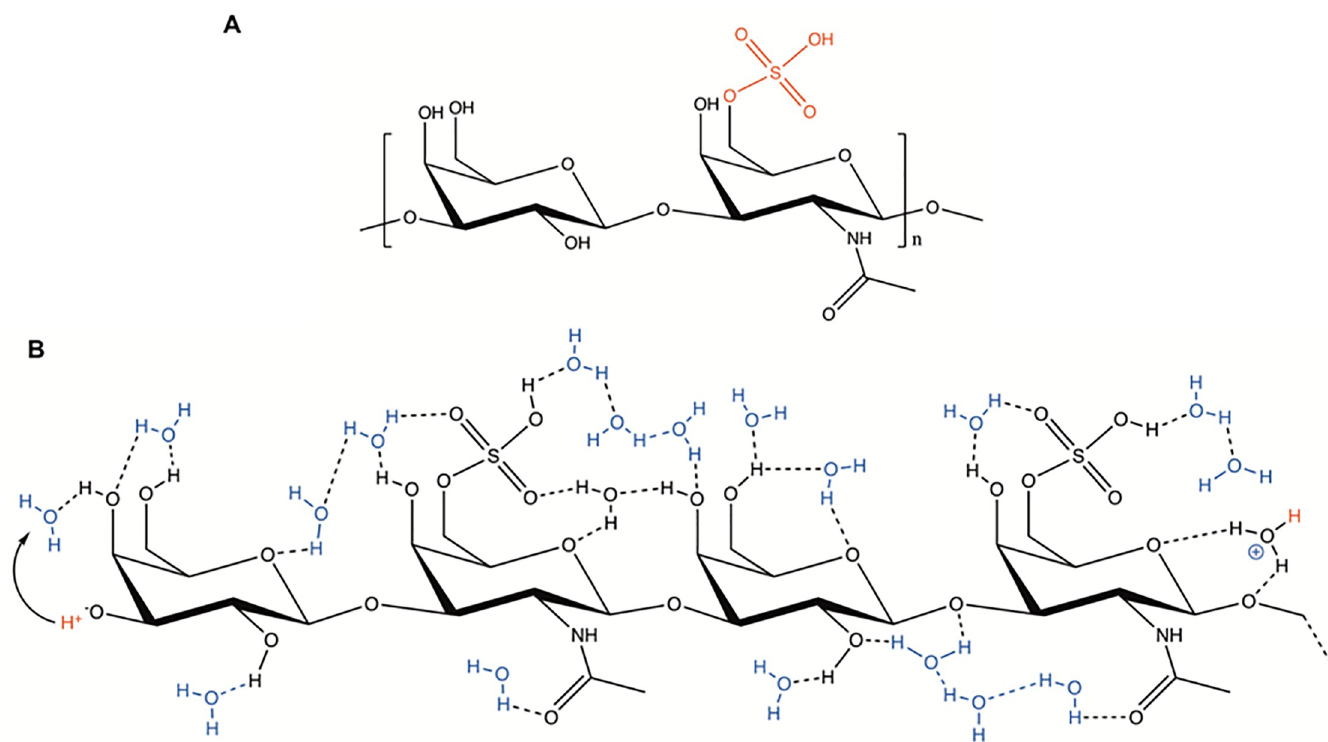
Fig 1. The keratan sulfate. (A) Chemical structure of KS. (B) An illustration of a three-monomer segment of KS. Possible intra- and inter-molecular hydrogen bonds as well as the hydrogen bonds between the water of hydration and the polar parts of the molecule form a continuous network comprised by hydrogen-bond chains. The sulfate group interacts with the hydrogen-bond network and forms an H 3 O + (hydronium) ion.